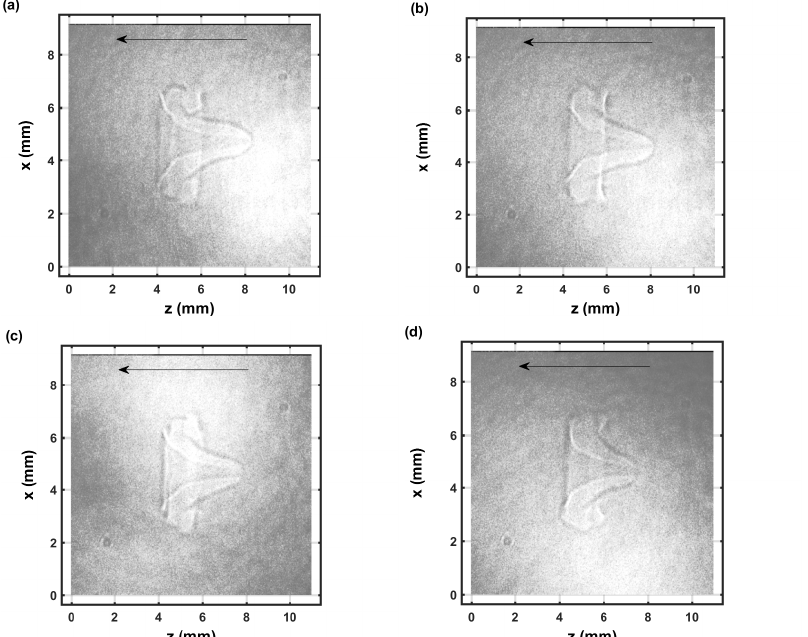
Figure 7. Single-shot shadow graph of the expanding laser-induced plasma initiated with a 170-mJ, 6-ns, 1064-nm focused beam, and imaged using a 5-ns, 532-nm back-light that shows intensity variations and is time-delayed by 104.25 µ s ( a – d ) display images from separate laser pulses.